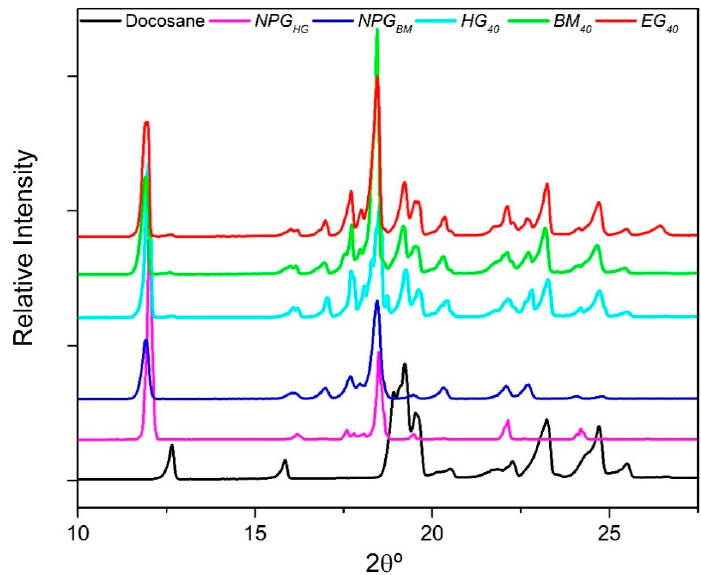
Figure 7. XRD diffractogram of Docosane, NPG and their mixtures containing 40 wt% of Docosane.